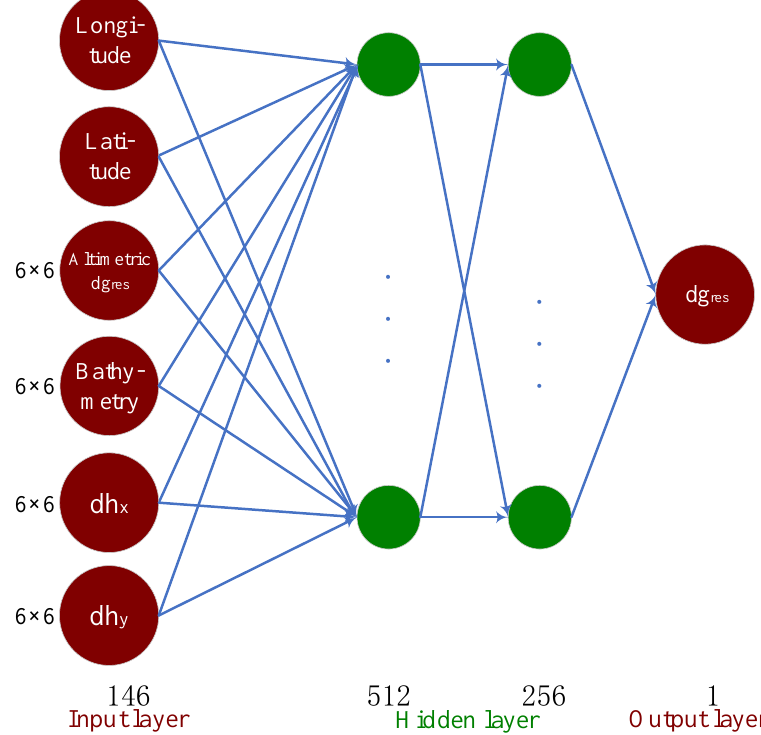
Figure 3. Structure of multi-layer perceptron (MLP): dh x and dh y are respectively prime vertical and meridian components of submarine topography slopes and dg res represents residual gravity anomalies.